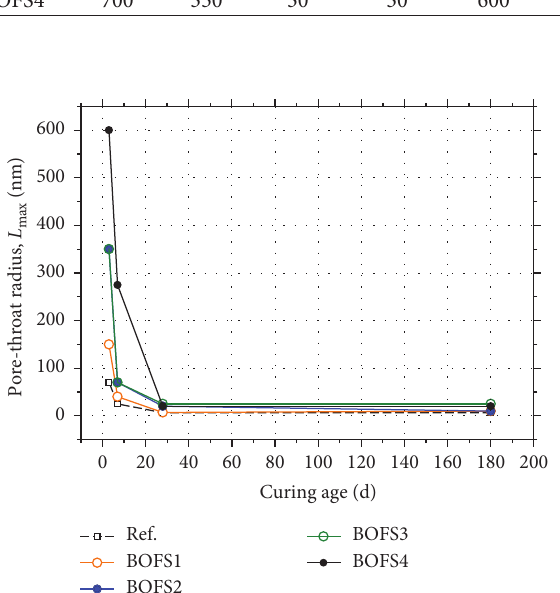
Figure 7: L max of cement pastes with BOFS at different curing ages.